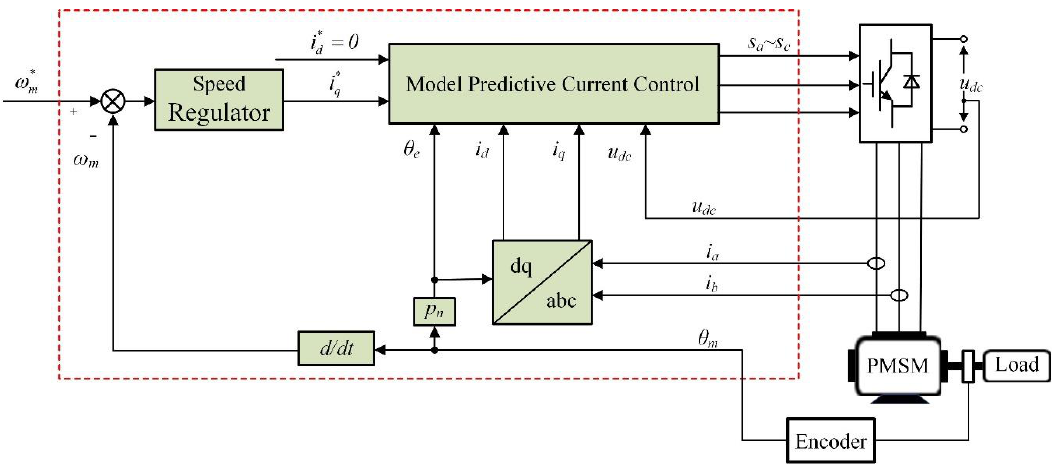
Figure 1. Studied model predictive current control permanent magnet synchronous motor (MPCC-PMSM) drive system.